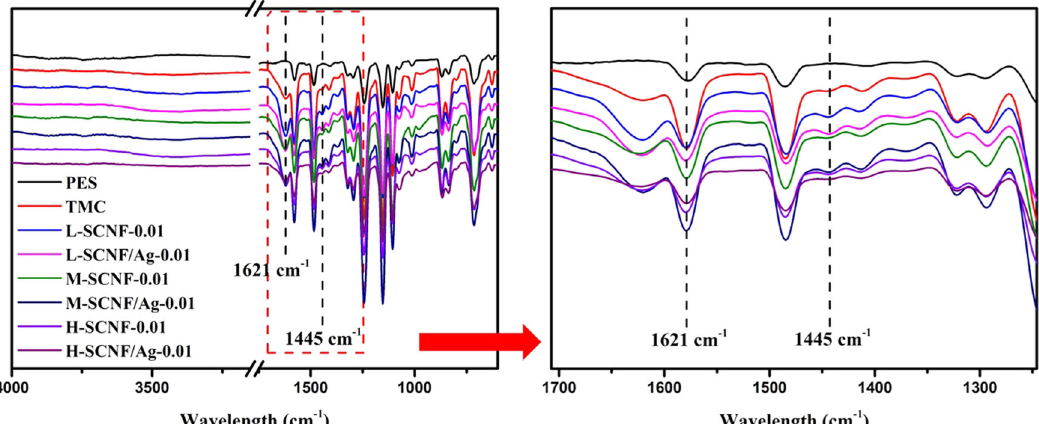
Fig. 2 FTIR spectra of composite NF membrane. FTIR spectra of PES substrate, SCNF composite NF membrane andSCNF/Ag composite NF membrane.